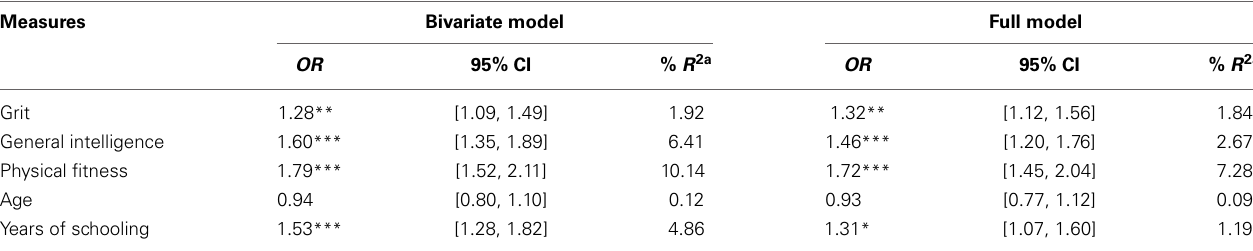
Table 1B | Bivariate and full logistic regressions predicting ARSOF retention (Study 1).